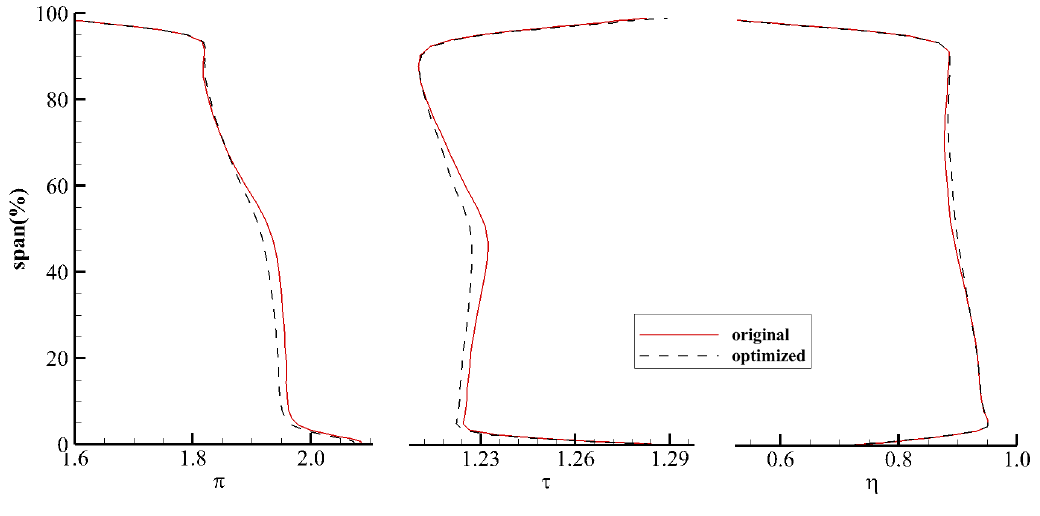
Figure 20. Radial distributions of rotor aerodynamic parameters at the peak efficiency point for the NASA Stage